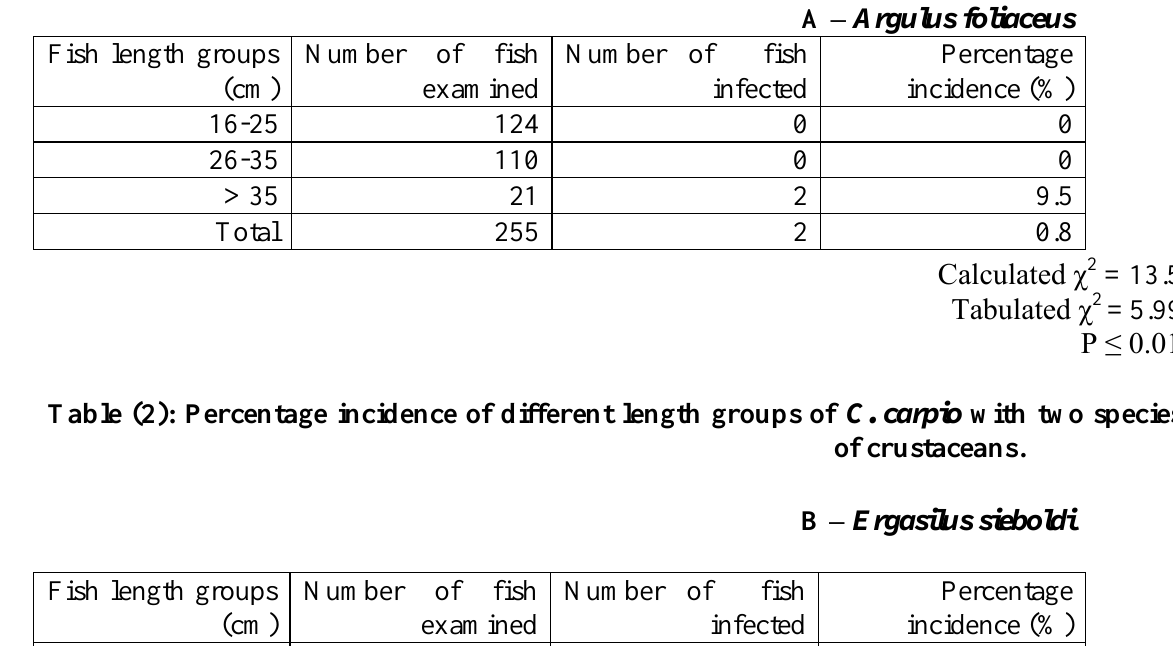
Table (1): Diagram showing classification of the parasites of C. carpio of the present study.